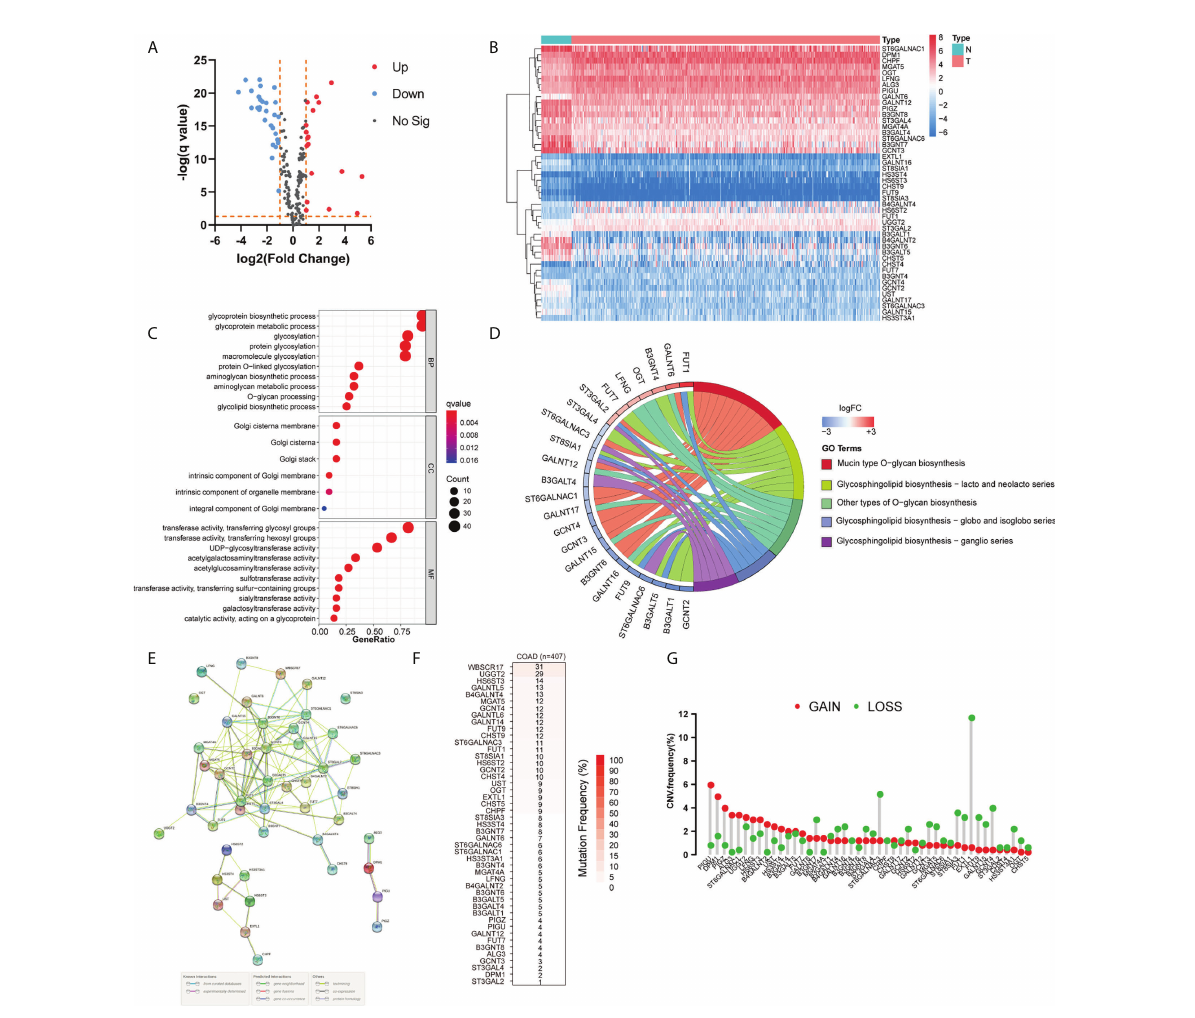
FIGURE 1 Landscape of genetic and expression variation of glycosyltransferase genes in COAD. (A, B) Volcano and heatmap visually showed differentially expressed genes between normal and COAD. (C, D) GO and KEGG analysis of DEGs. (E) Protein – protein interaction (PPI) network showing the interaction between DEGs among glycosyltransferases. (F) The SNV mutation frequency of DEGs in the COAD cohort. (G) The CNV variation frequency of DEGs in COAD. The height of the column represented the alteration frequency. N, normal tissues; T, tumor; BP, biological process; CC, cellular component; MF, molecular function; FC, fold